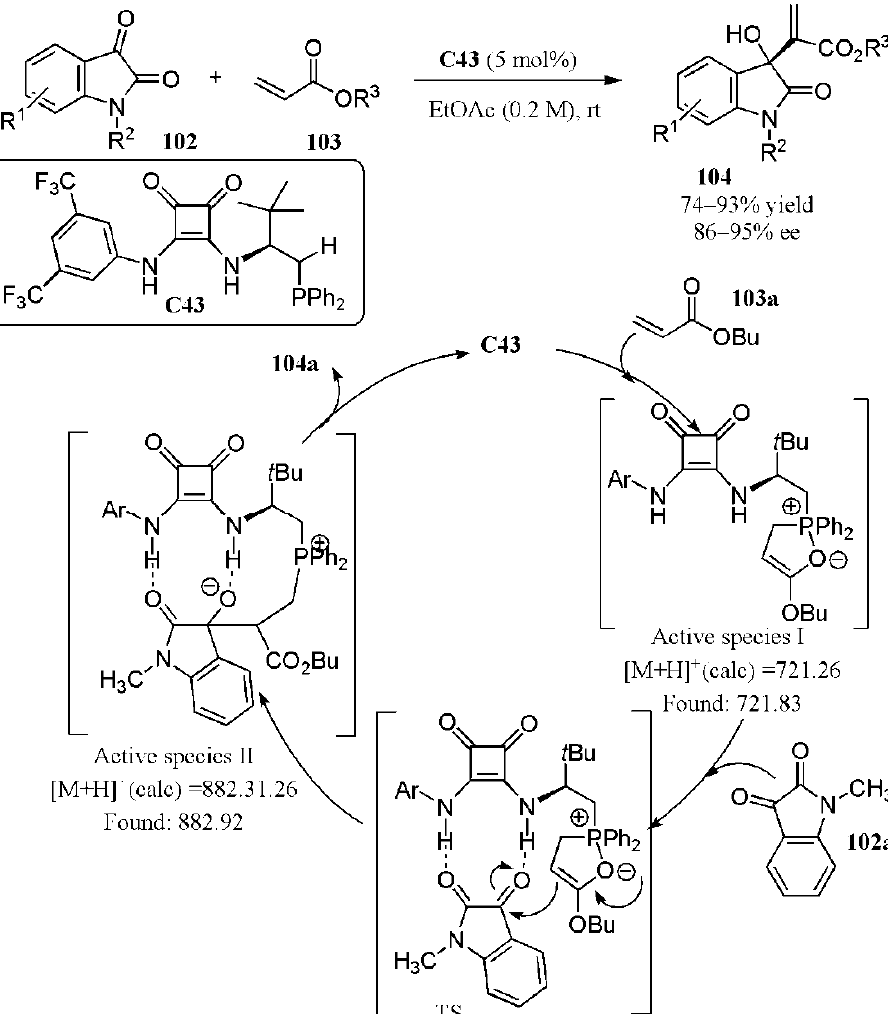
Figure 53. Enantioselective Morita–Baylis–Hillman reaction of N -alkyl isatins with acrylates and the mechanism proposed [102].